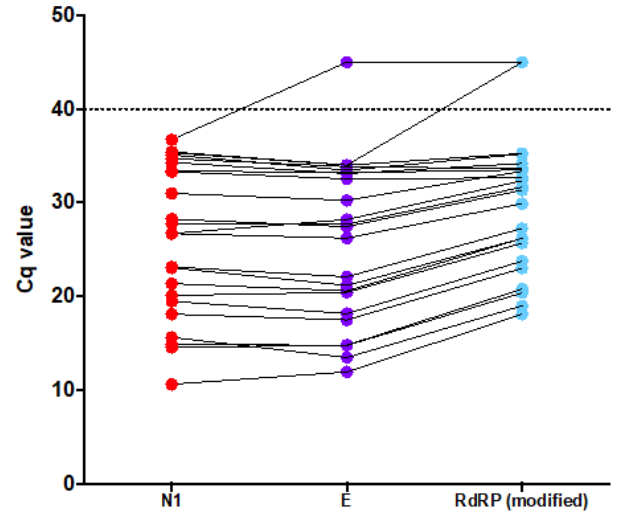
Figure 5. Cq values observed for the first 23 positive samples detected by the first version of the proposed method: N1 (red), E (magenta) and RdRP modified (R) (light green). N1 and E showed lower Cq values than RdRP (modified). Dashed line depicts the cut-off value of >40.